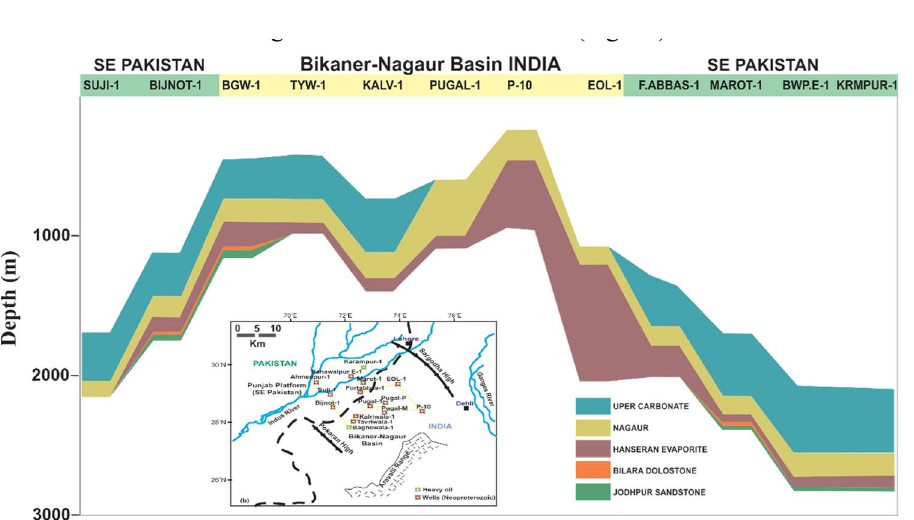
Figure 17. Subsurface correlation of Neoproterozoic sequences (the Nagaur, Hanseran, Bilara, and Jodhpur Formations) in SE Pakistan and the BK–N Basin in